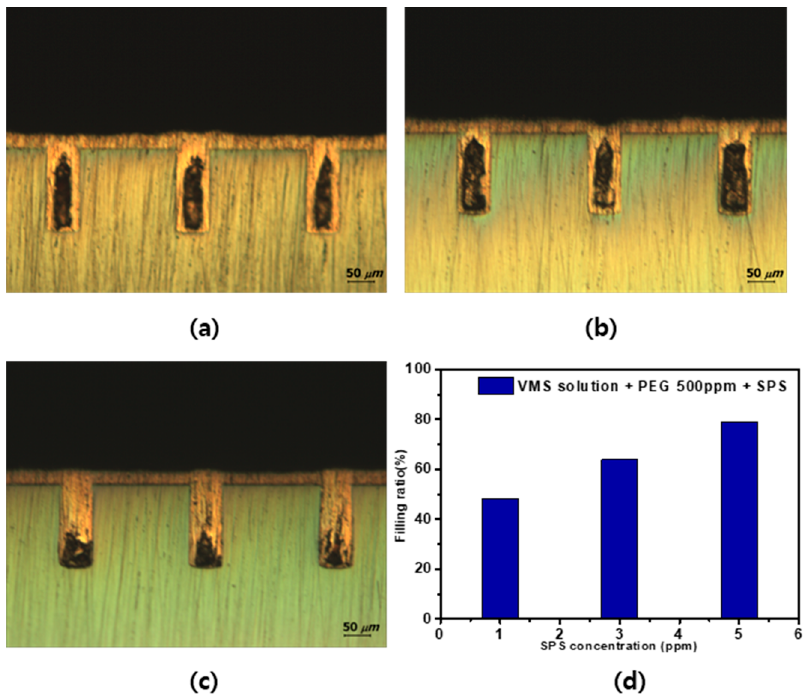
Figure 7. ( a – d ) Images of changing SPS concentration in a VSM bath with 500 ppm PEG: ( a ) SPS 1 ppm, ( b ) SPS 3 ppm, ( c ) SPS 5 ppm, and ( d ) filling ratio graph for AR 1:2.5 TSV.